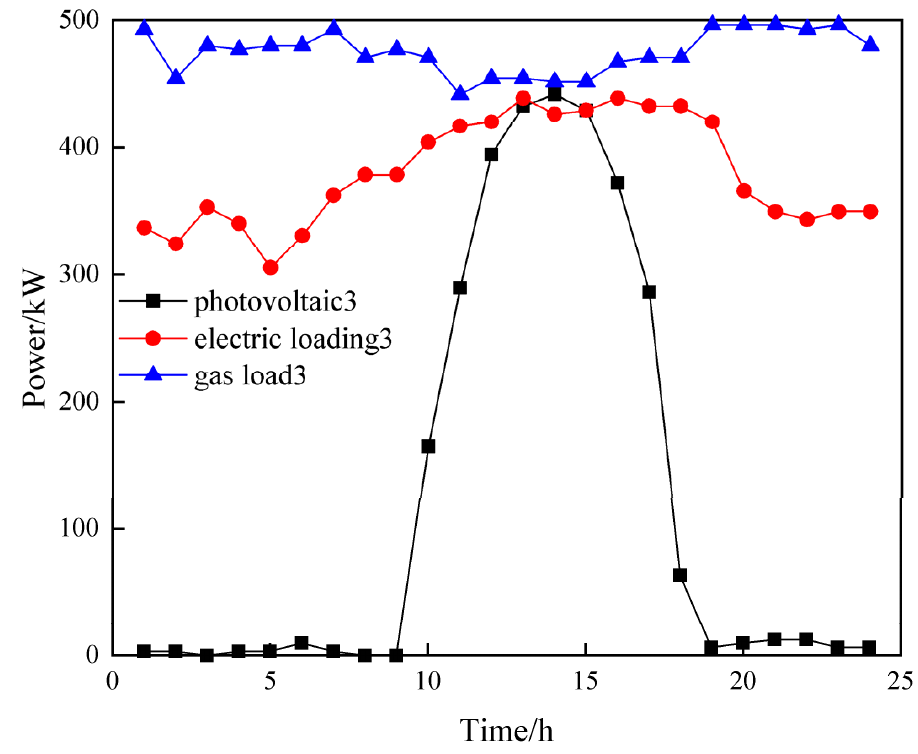
Energies 2022 , 15 , x FOR PEER REVIEW Figure 4. Predicted values of renewable energy output and load in system 2. Figure 4. Predicted values of renewable energy output and load in system 2.